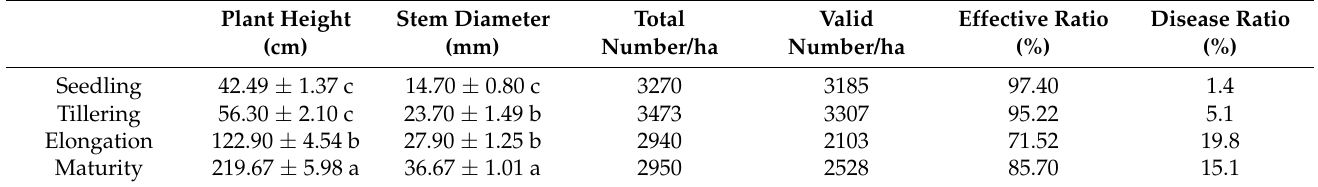
Table 1. Changes in phenotypic indicators of sugarcane at different growth stages.